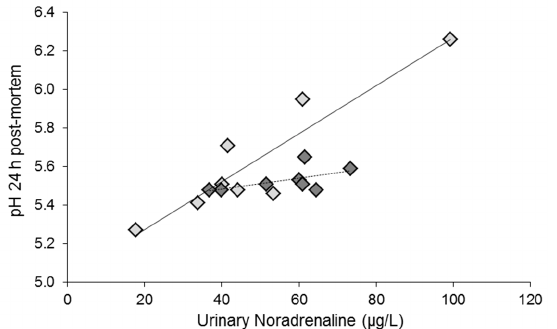
Figure 7. The slopes of correlations between the noradrenaline (NA) content of urine obtained just after slaughter and the pH of the Longissimus lumborum measured 24 h postmortem depended on the slaughter method. Pigs had been slaughtered either following mixing and transport to the abattoir the day before slaughter (light-gray symbols; pH = 5.02 + 0.00001 × NA; r = 0.92; p = 0.001) or without mixing, immediately following transport (dark-gray symbols; pH = 5.37 + 0.000003 × NA; r = 0.57; p = 0.14). The slopes differ p = 0.004 (ANCOVA on pH; NA content × slaughter method: p = 0.02). Data from [120] and adapted from [61], with permission from INRAE, 2020. Urinary noradrenaline reflects the amount of noradrenaline secreted into the blood over several tens of minutes preceding the sample collection